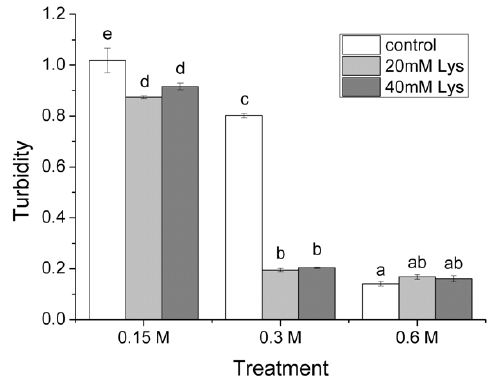
Figure 2. The effects of Lys on the turbidity of MFP solutions at different ionic strengths. Columns with different letters indicate significant differences at the level of p < 0.05. 0.15 M, treatment with ionic strength of 0.15 M NaCl; 0.3 M, treatment with ionic strength of 0.3 M NaCl; 0.6 M, treatment with ionic strength of 0.6 M NaCl; control, treatment without Lys addition; 20 mM Lys, treatment with 20 mM Lys; 40 mM Lys, treatment with 40 mM Lys.